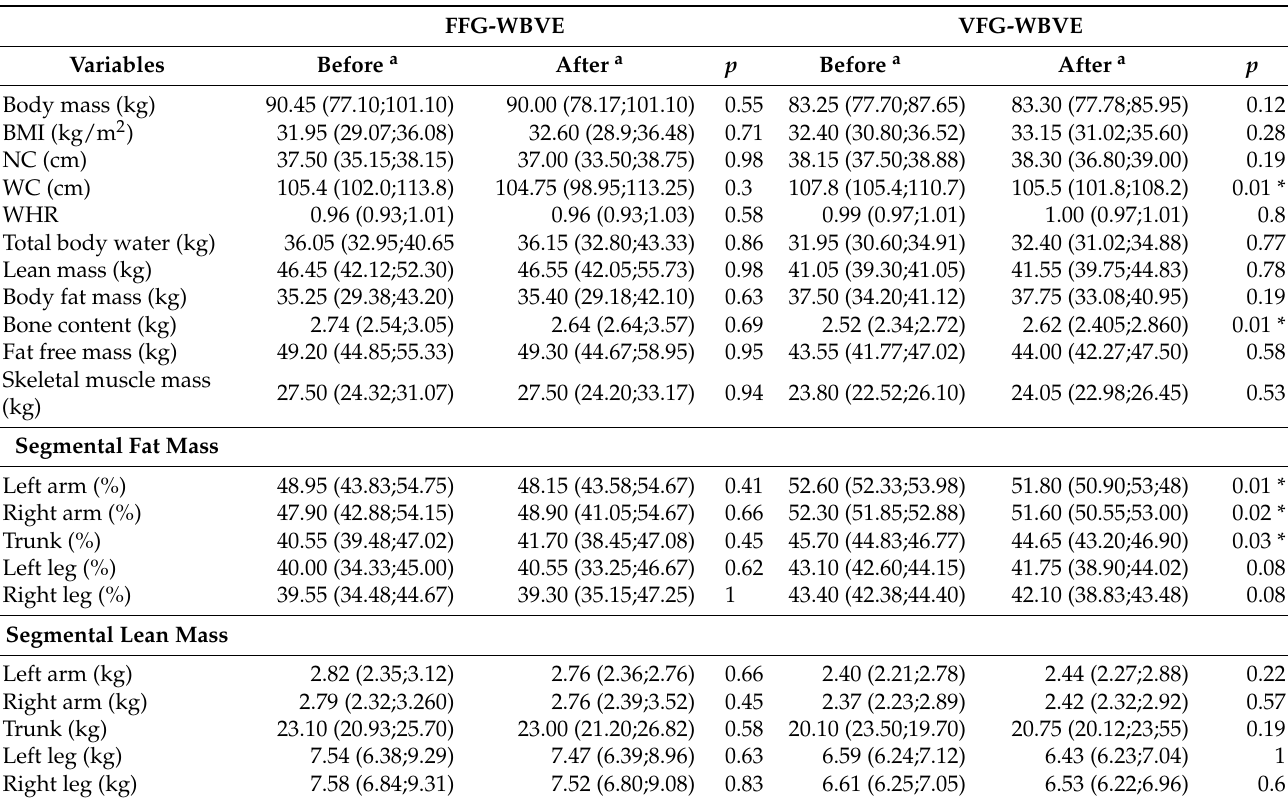
FFG-WBVE (fixed frequency group-WBVE); BIA (bioelectral impedance analysis); VFG-WBVE (variable frequency group-WBVE); WBVE (whole-body vibration exercise); BMI (body mass index); NC (neck circumference); WC (waist circumference); WHR (waist-to-hip ratio); a -Median (1st; 3rd quartiles) * p ≤